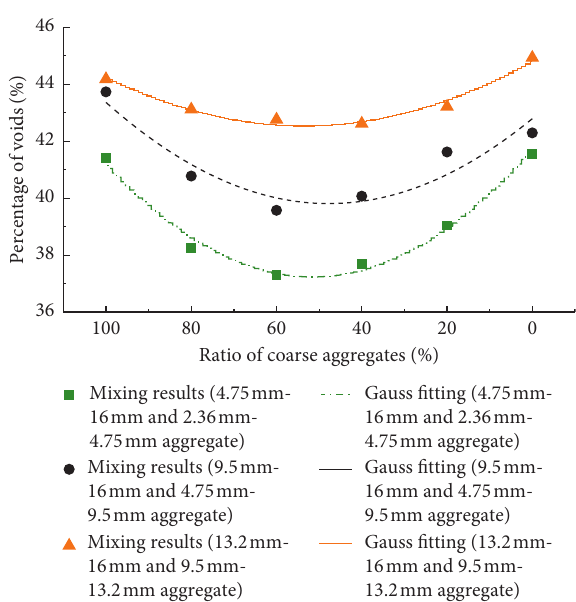
Figure 7: Percentage of void fitting